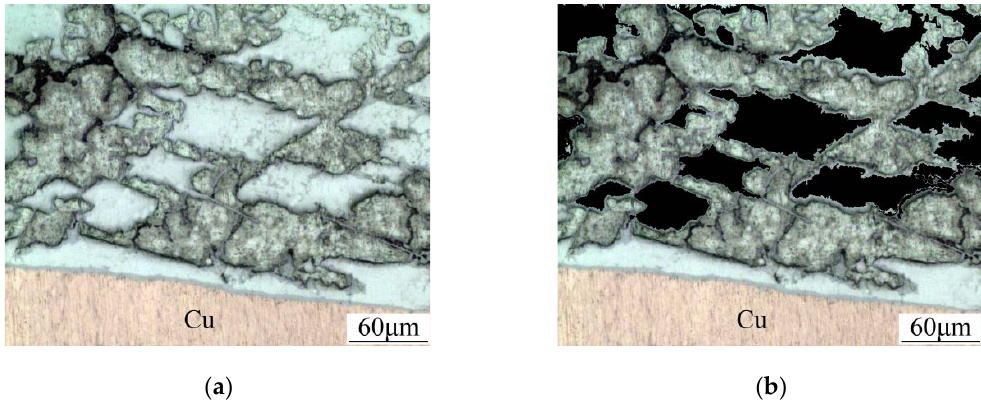
Figure 2. The schematic diagram for the calculation of the IMC layer area.